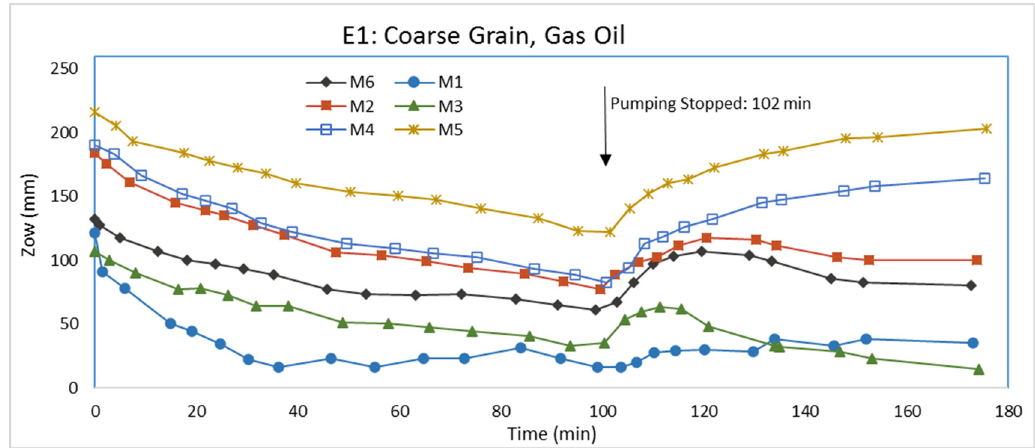
Figure 5. LNAPL-water interface elevation (Zow) variations in E1.